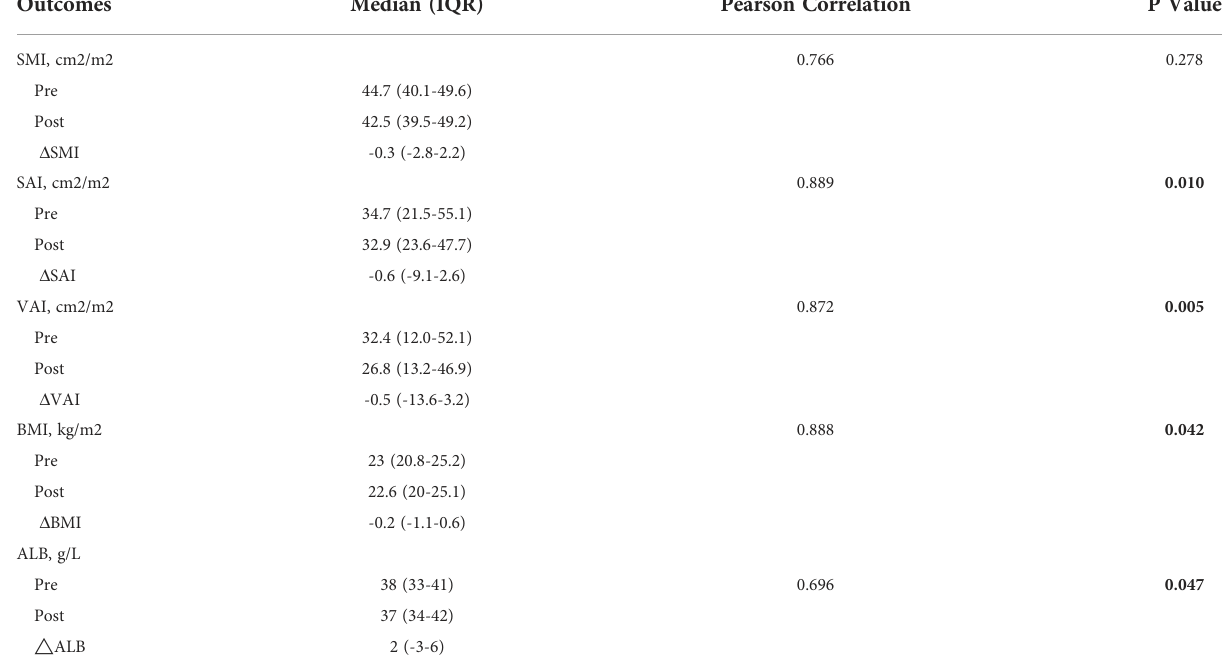
TABLE 2 Changes of body composition and albumin in neoadjuvant therapy.